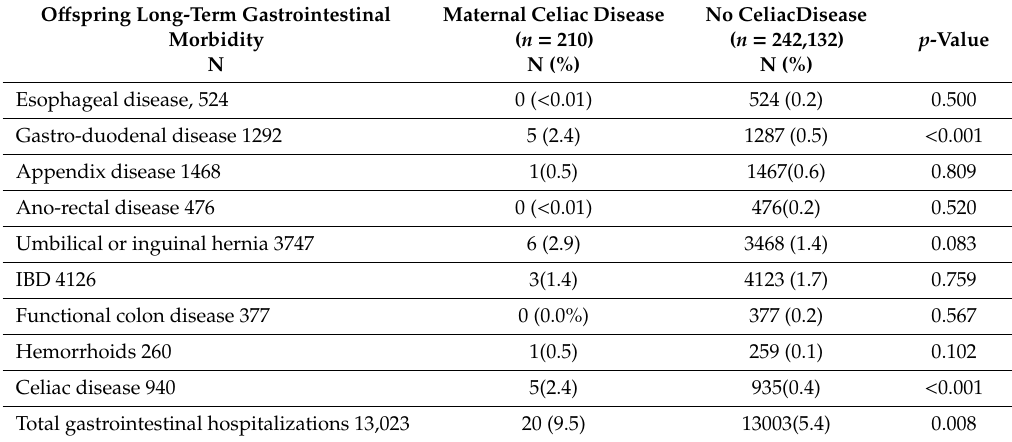
Table 3. Association between maternal celiac disease and long-term gastrointestinal morbidity of the o ff